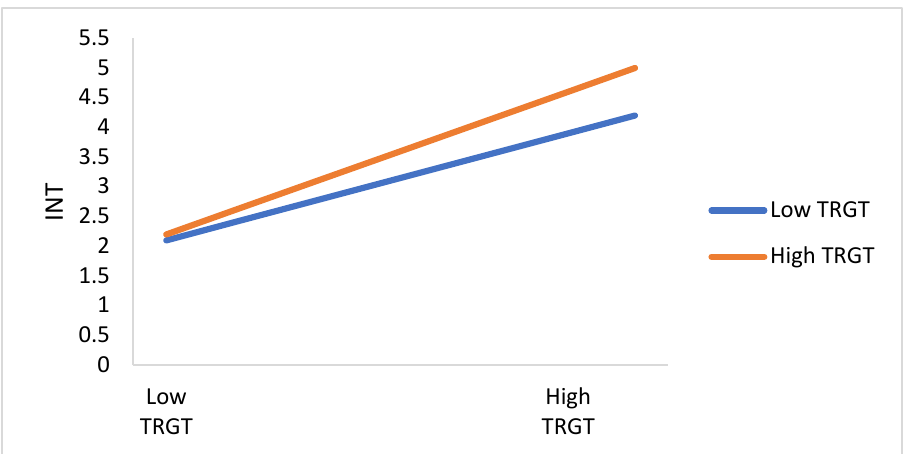
Figure 6. The plot of the moderating effect of health infodemics on the relationship between TRGT and INT.